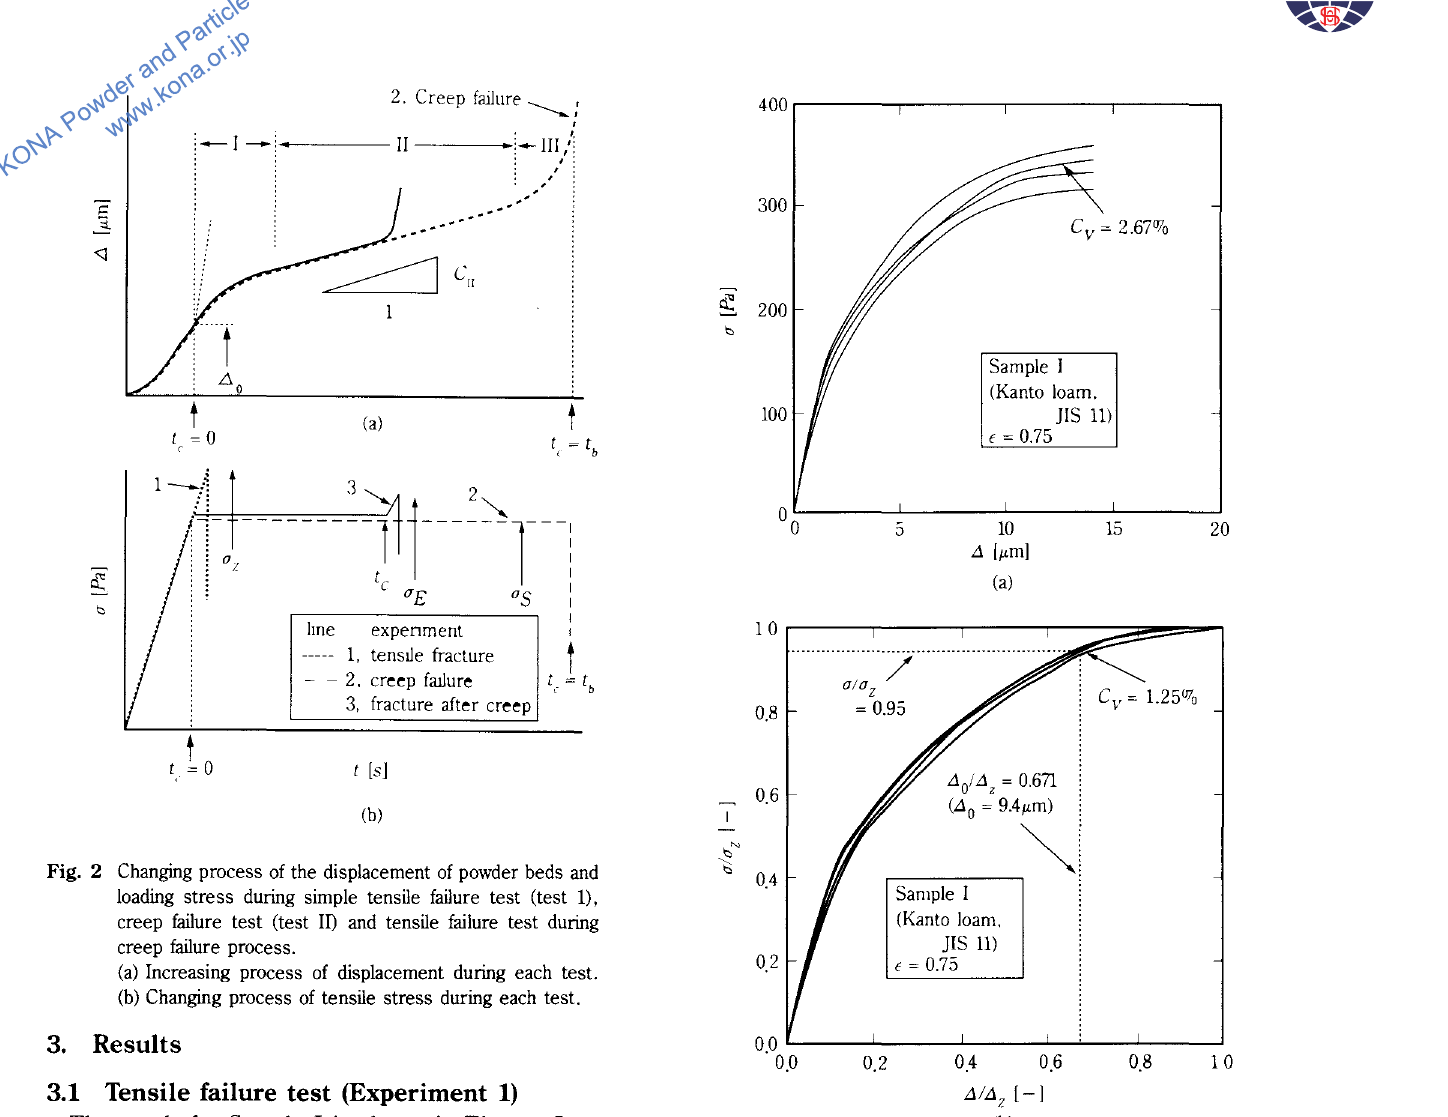
Fig. 3 Examples of tensile stress and displacement relations during simple tensile failure test (test